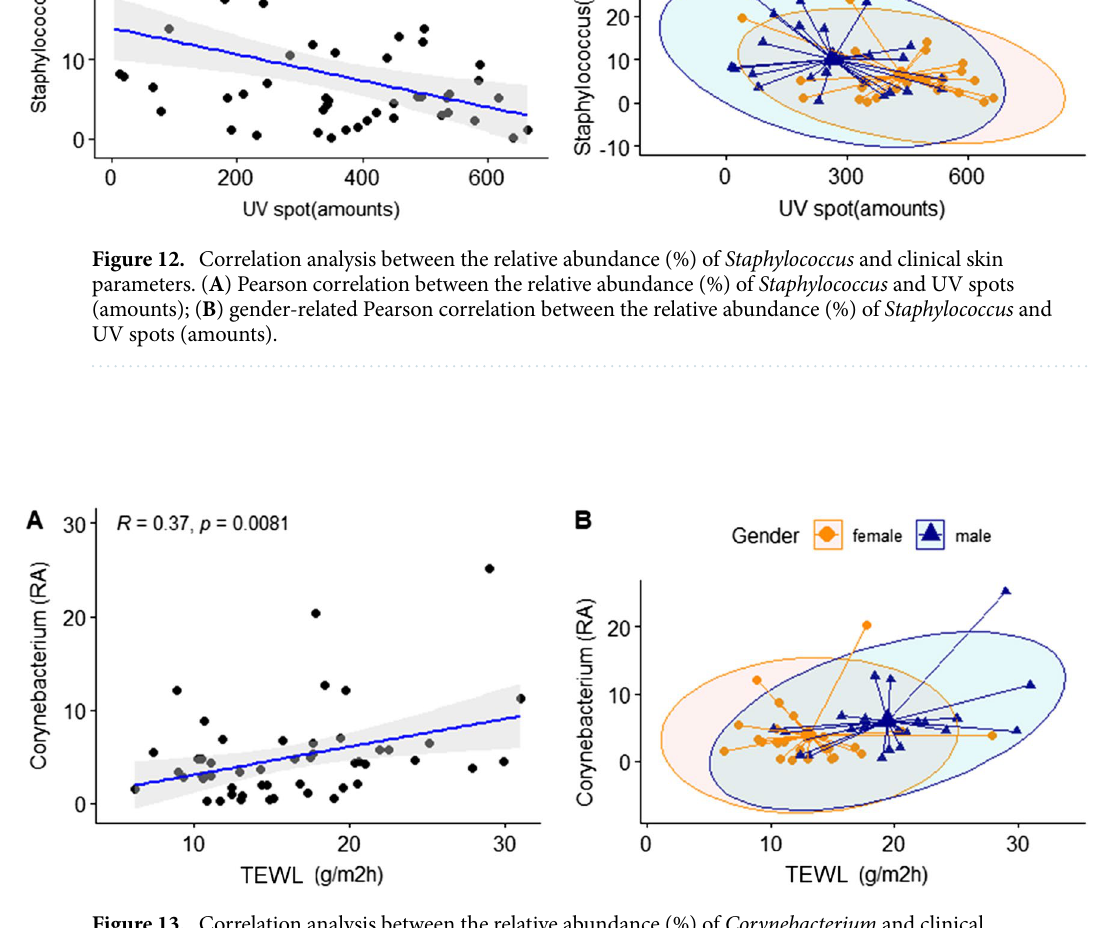
Figure 13. Correlation analysis between the relative abundance (%) of Corynebacterium and clinical skin parameters. ( A ) Pearson correlation between the relative abundance (%) of Corynebacterium and transepidermal water loss (g/m 2 h); ( B ) gender-related Pearson correlation between the relative abundance (%) of Corynebacterium and transepidermal water loss (g/m 2